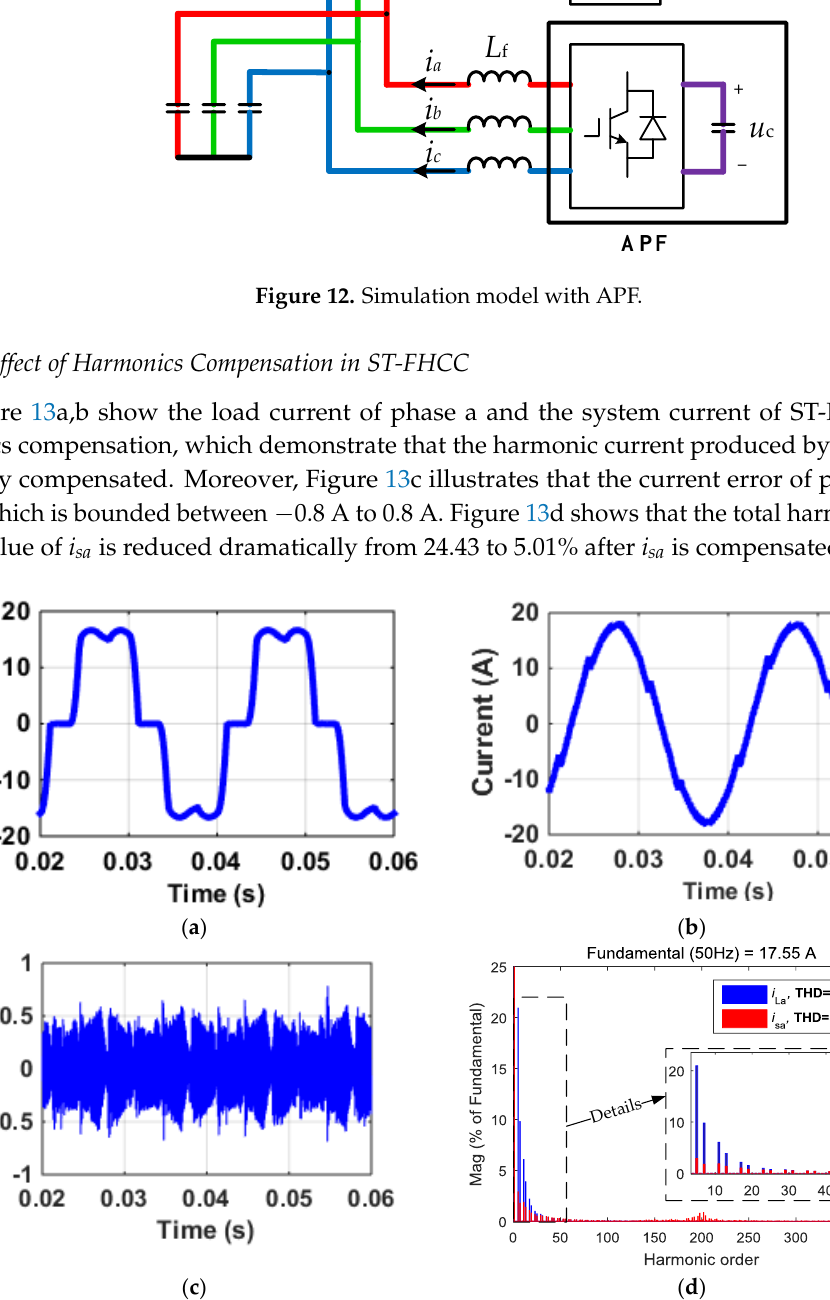
Figure 13. Load current, current supplied by power system after compensation, and current error of phase a between actual current of phase a and its reference. ( a ) current i La ; ( b ) current i sa ; ( c ) current error of phase a between actual; ( d ) THDs of i La and i sa current of phase a and its reference.